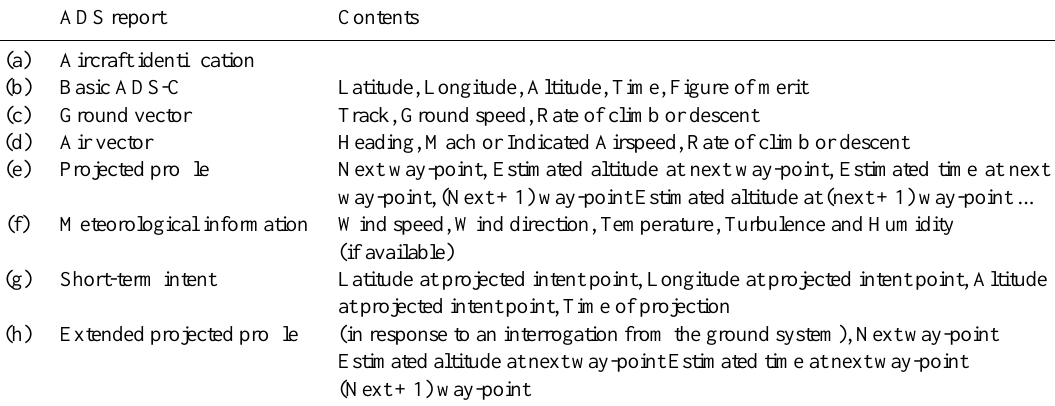
Table 1. Contents of ADS-C, from ICAO (2007).